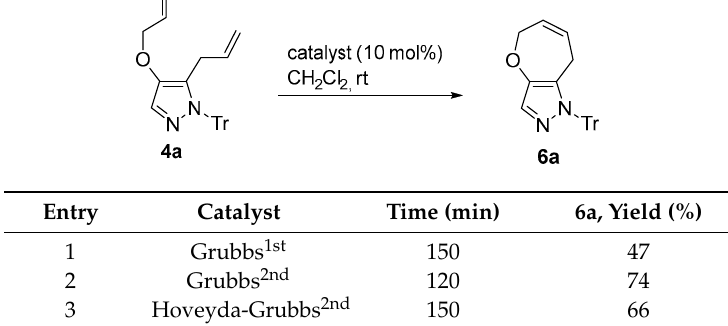
Table 2. Ring-closing metathesis (RCM) of 4a with various Grubbs catalysts.